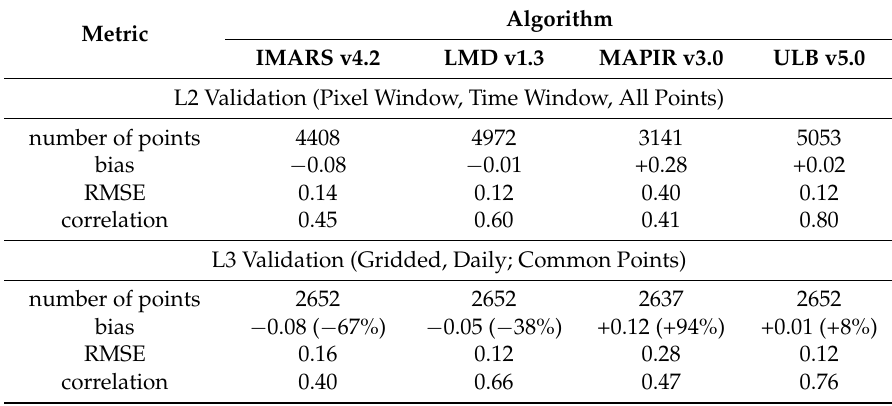
Figure 11. Scatter density plots (upper line) and difference histograms of dust AOD at 550 nm for the four IASI datasets (4 columns from left to right: DLR/IMARS (Infrared Mineral Aerosol Retrieval Scheme), LMD, BIRA/MAPIR (Mineral Aerosol Profiling from thermal Infrared Radiances), ULB) vs. AERONET SDA (Spectral Deconvolution Algorithm) coarse mode AOD at 550 nm for the region 80 ˝ W to 120 ˝ E and from 0 ˝ N to 40 ˝ N over the whole year 2013. The red lines show the linear regression fit. Table 12. Validation of IASI AOD at 550 nm for the four datasets (L2 and L3) against AERONET SDA coarse mode AOD at 550 nm for the region 80 ˝ W to 120 ˝ E and from 0 ˝ N to 40 ˝ N over the whole year 2013 for L2 (satellite projection) and L3 (gridded) datasets.